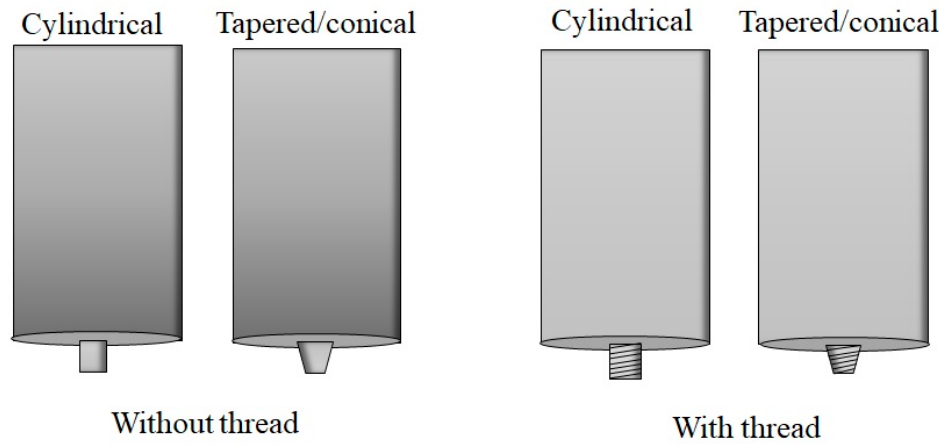
Figure 12. Schematic of common tool pin shapes in FSW of non-heat-treatable aluminum.